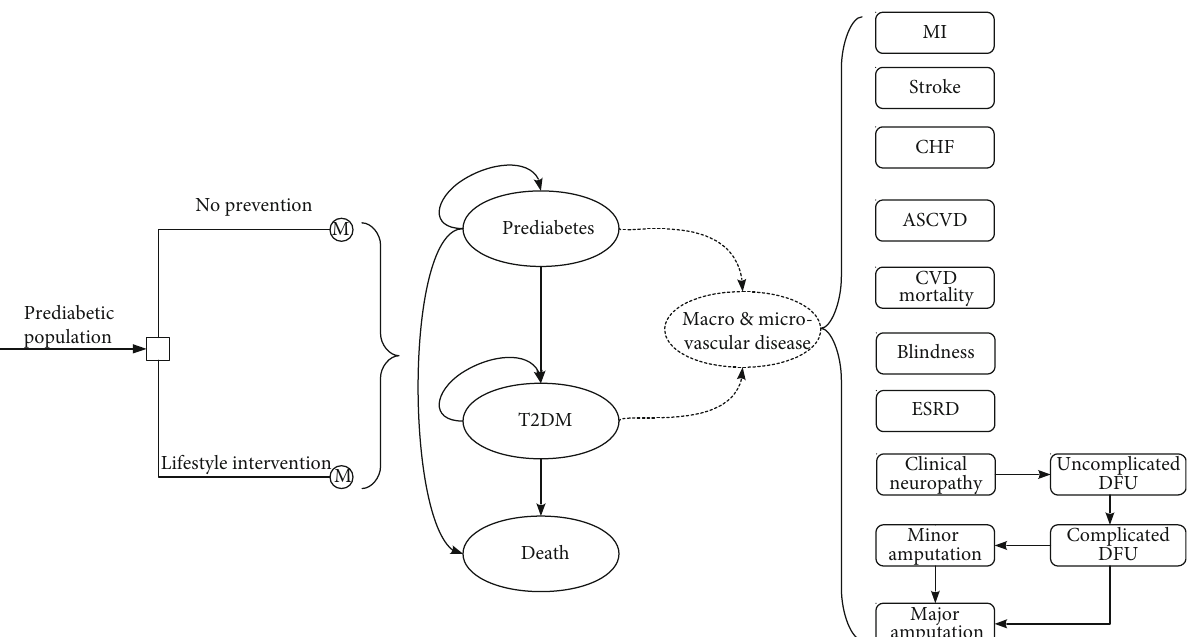
Figure 1: Schematic of type 2 diabetes mellitus prevention